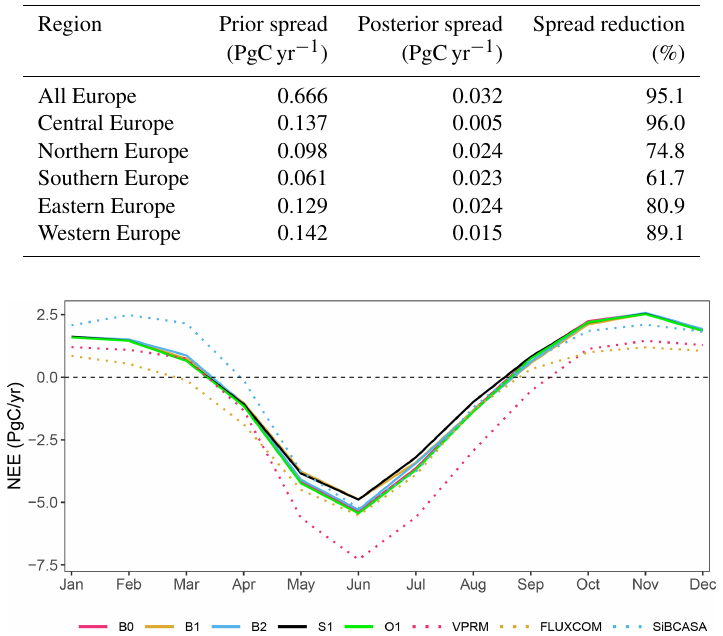
Figure 4. Seasonal cycle of NEE calculated as the average of monthly fluxes over 13 years estimated using the ensembles of inversions (solid lines) B0, B1, B2, S1, and O1 as well as the biogenic prior fluxes (dotted lines) obtained from VPRM, FLUXCOM, and SiBCASA.